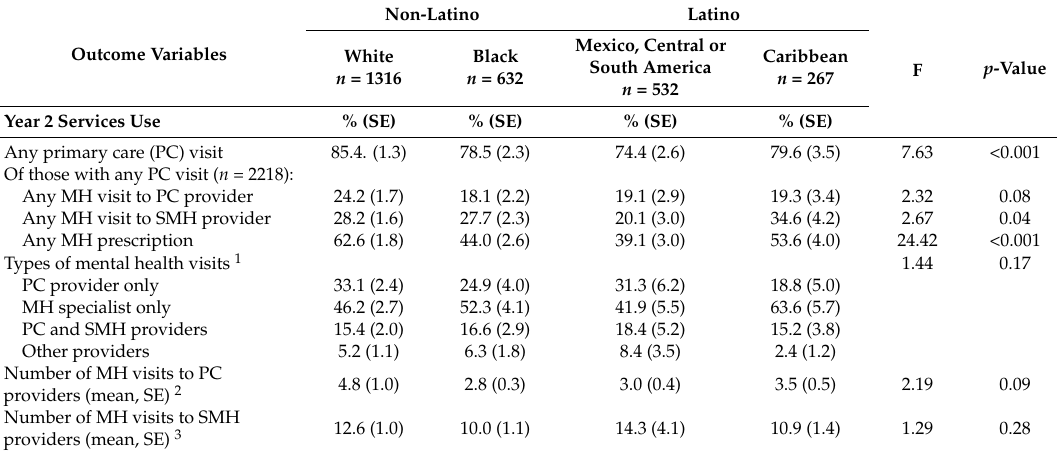
Table 2. Primary Care and Mental Health Service Visits among Non-Latino White, Non-Latino Black, and Latino Adults with Serious Psychological Distress,